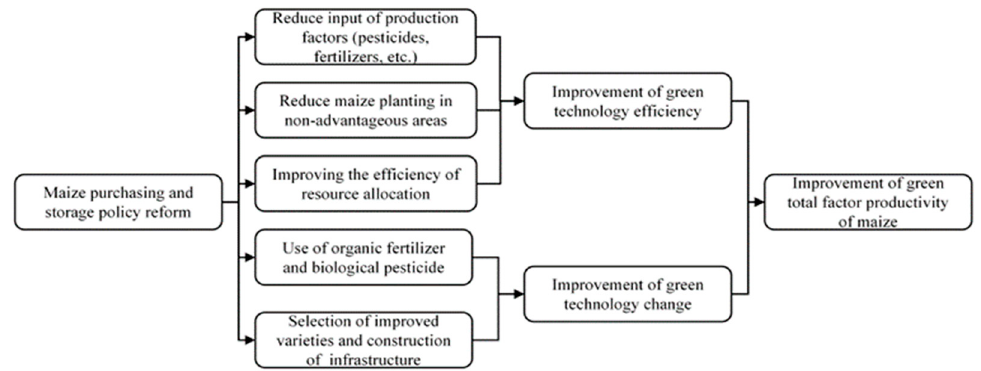
Figure 1. Impact mechanism diagram.